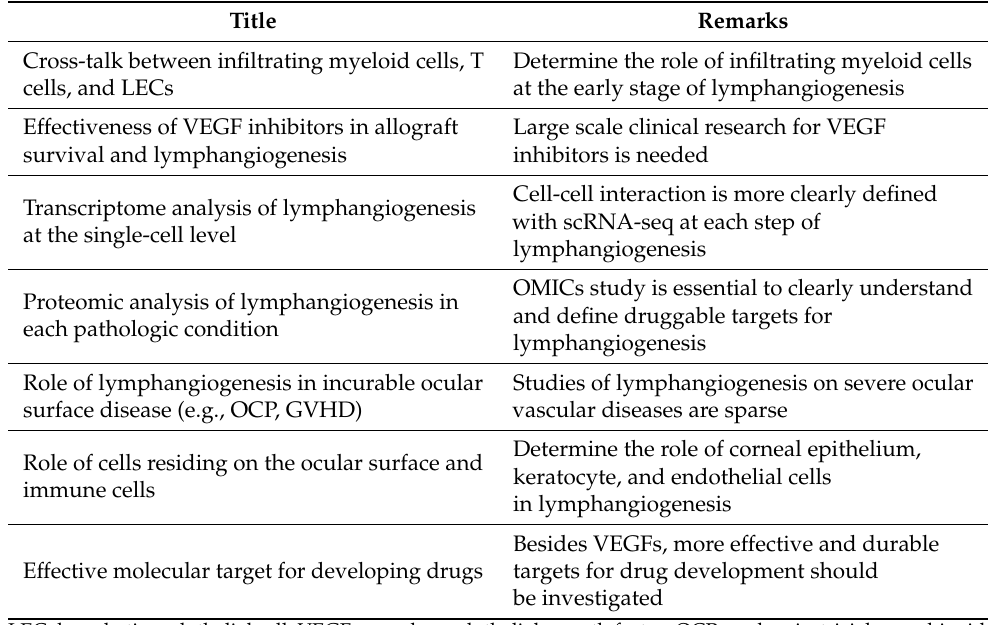
Table 4. Unmet needs to be investigated for ocular surface